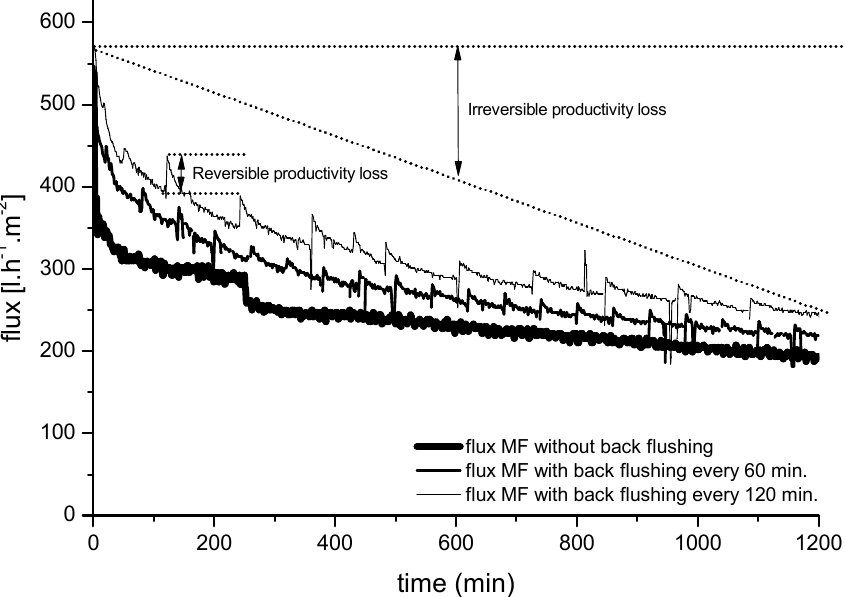
Figure 7. Influence of back flushing frequencies (60 and 120 min) on permeate flux through a 0.1-µm ceramic MF membrane (mono-channel design) during the filtration of bleaching effluents. TMP = 2 bar; temperature = 60